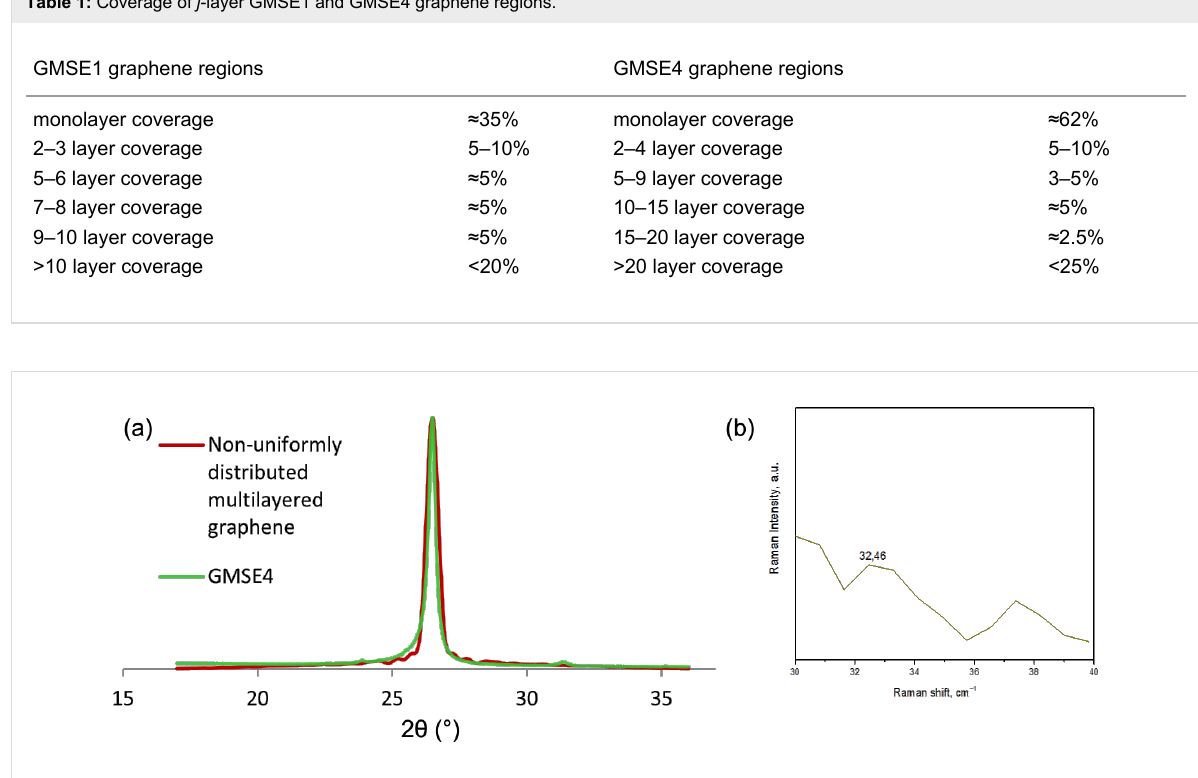
Figure 5: (a) Nonuniform multilayer distribution curve for sample GMSE4 calculated from Equation 1; (b) C -peak position in Raman spectrum for graphene sample GMSE4.